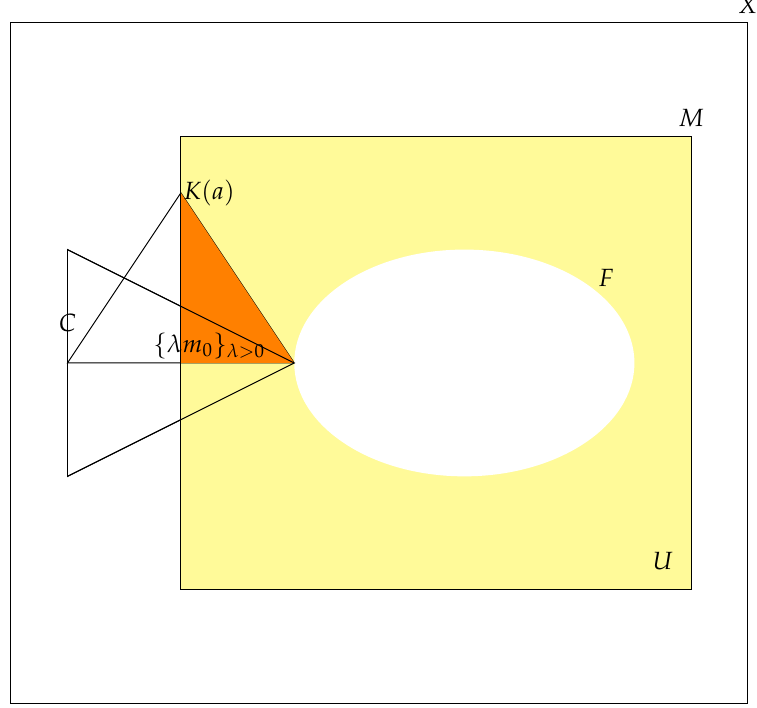
Figure 8. In yellow, elements in M with a unique (positive) price. In orange, elements in K ( a ) with a unique (positive) price. In white, elements in F with a unique (negative or null) price. Source: Own